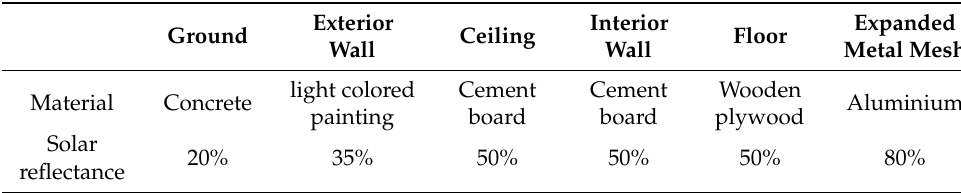
Table 4. Material setting for DIVA of lighting experiment.